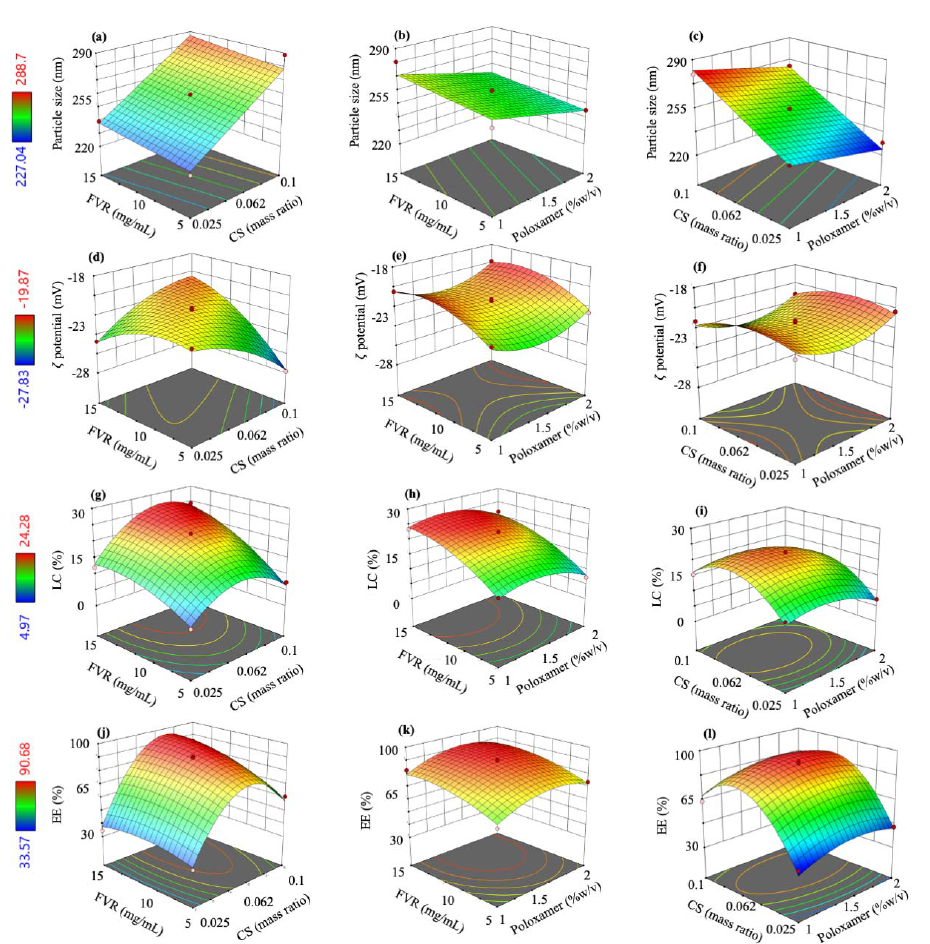
Figure 1. Three-dimensional (3D) surface model plots showing the interaction between the inde- pendent factors to ( a – c ) size, ( d – f ) ζ potential, ( g – i ) LC, and ( j – l ) EE.